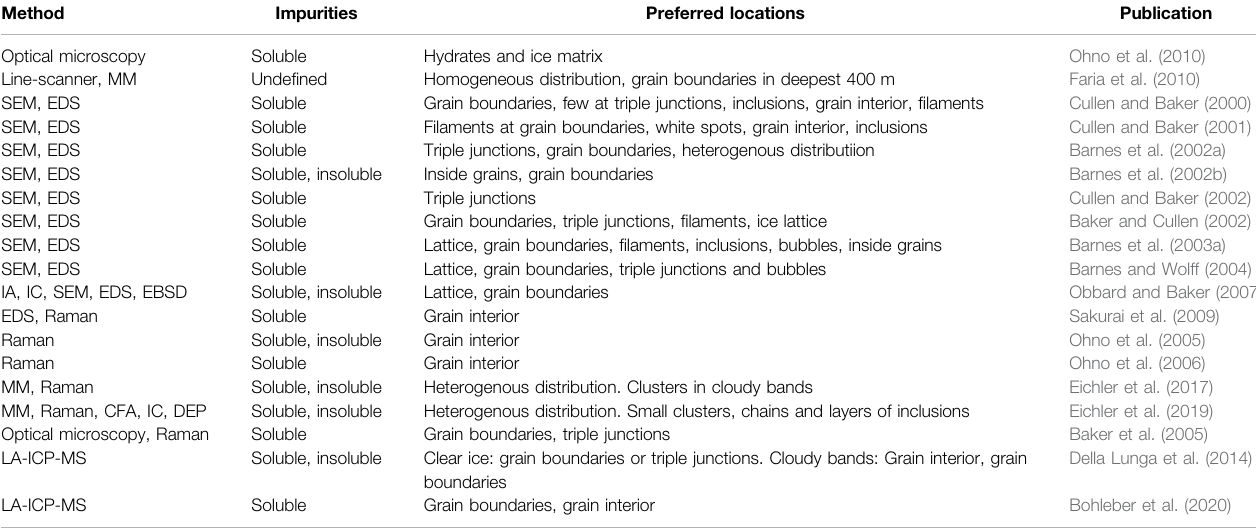
TABLE 1 | Studies on impurities in polar ice, sorted by method. Method